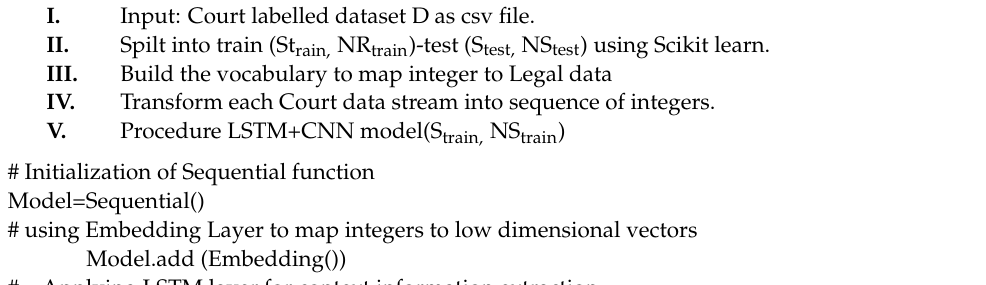
Algorithm 3: Pseudocode of proposed Court Case Judgments Prediction model.